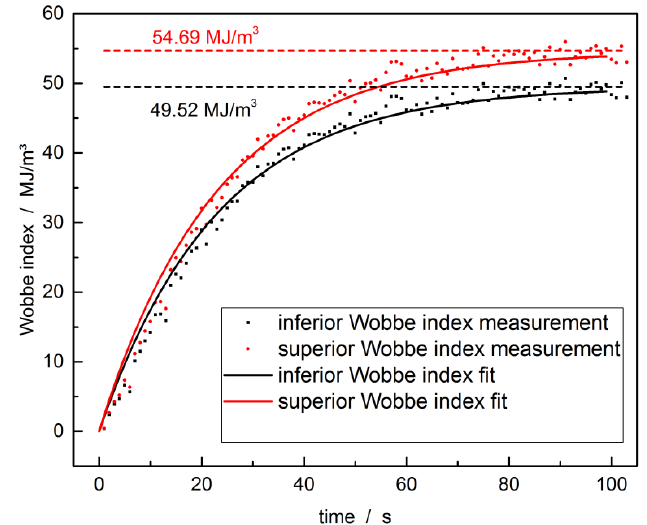
Figure 10. Inferior and superior Wobbe indices during gas exchange in the 80 cm long kagomé-PCF with 2 bar pressure and 28 mW laser power. Dots mark the indices calculated from concentration measurements. The curves are exponential growth fits. The horizontal lines mark the Wobbe indices calculated from the manufacturer specifications for the chosen natural gas mixture. Please note that the venting valve was not employed in this